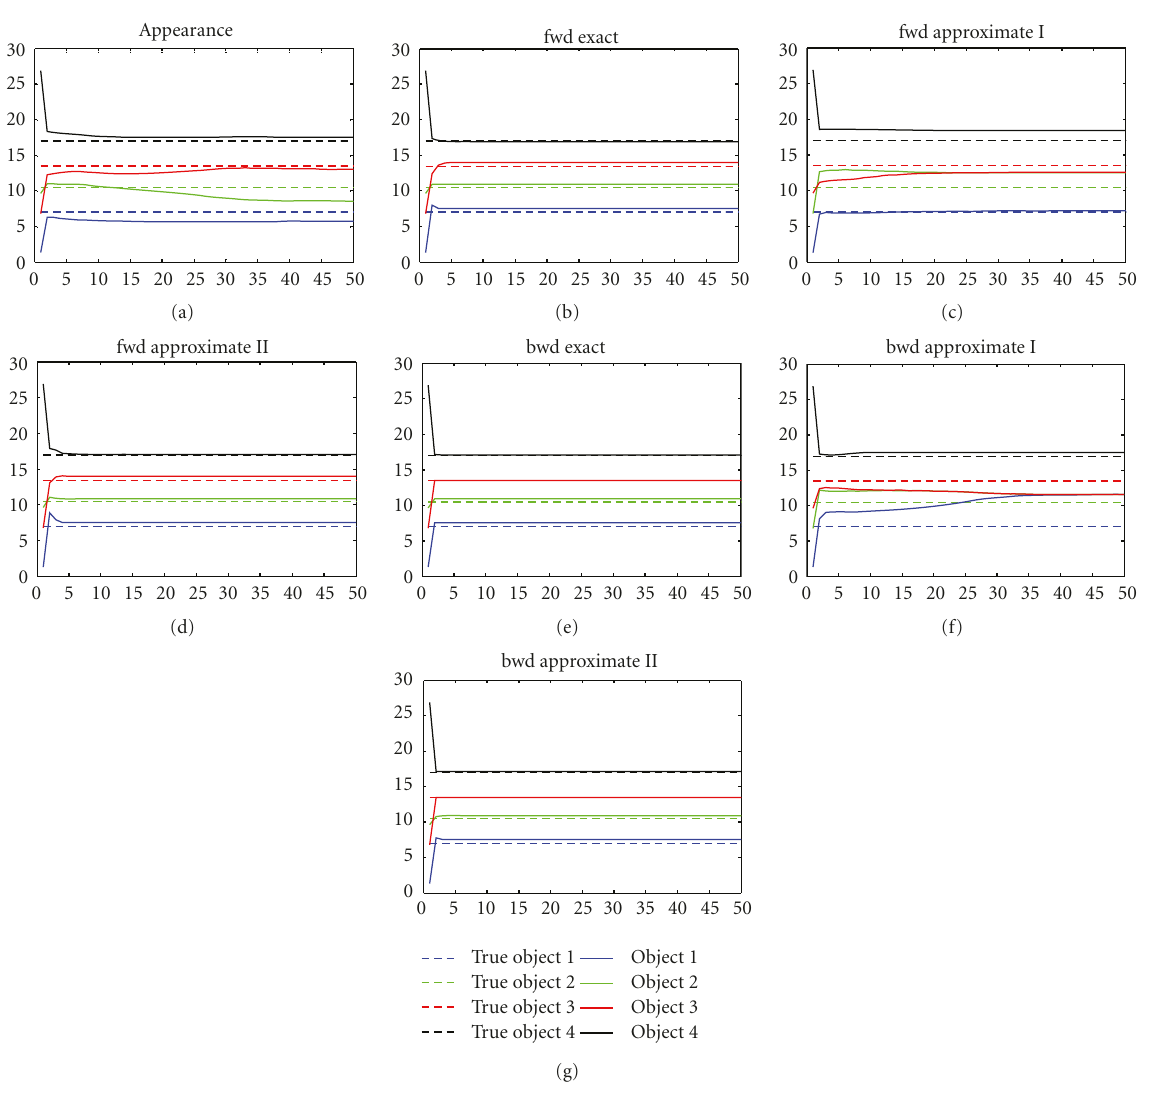
Figure 12: Parameter learning curve of EM with di ff erent inference algorithms. (a) Standard EM. (b) Forward exact. (c) Forward appr.I. (d) Forward appr.II. (e) Backward exact. (f) Backward appr.I. (f) Backward appr.II. Table 2: Means of the accuracy of exact inference in case of missing detection (%). Missed